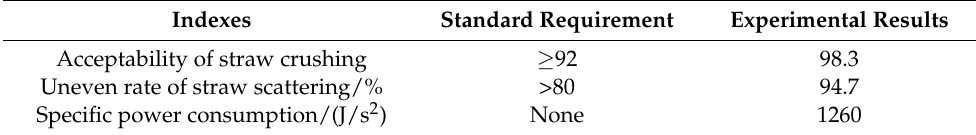
Table 5. Influence of conveying and feeding speed on evaluation index.